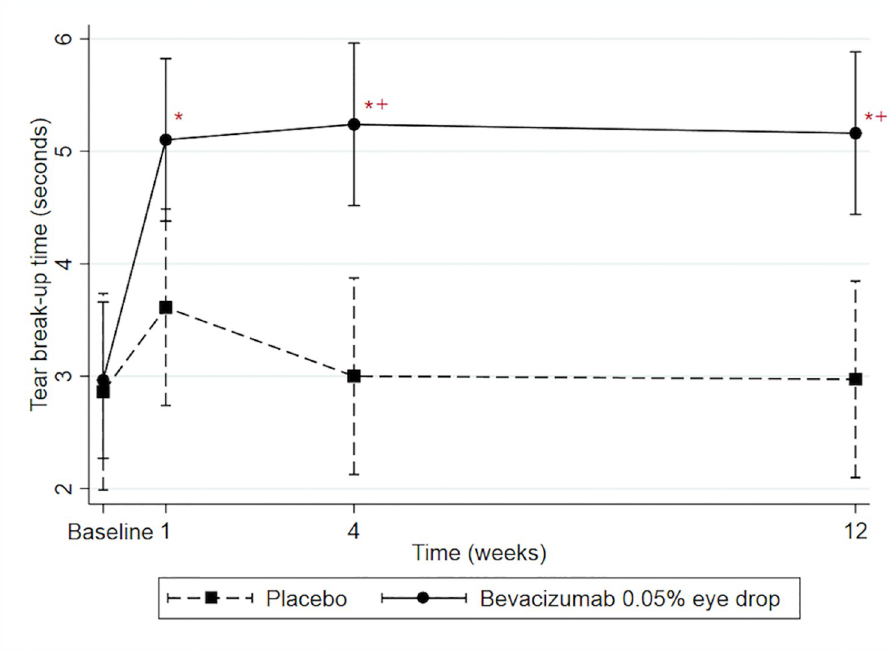
Fig 2. Predicted mean tear break-up time (TBUT) with 95% confidence intervals. � Represents significant difference compared with baseline within group (P < 0.05). + Represents significant difference in the difference of TBUT between bevacizumab 0.05% eye drops group and placebo group compared with the difference between the two groups at baseline (P < 0.05).